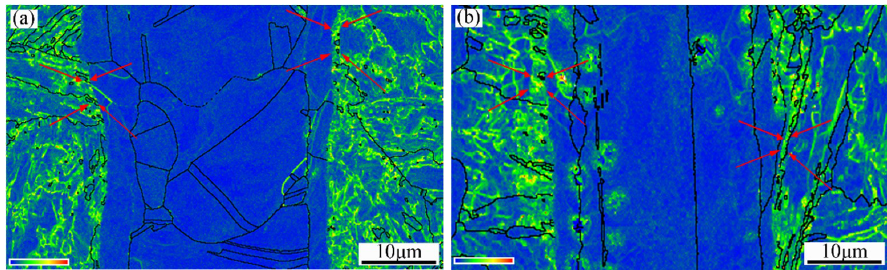
Figure 9. Kernel average misorientation (KAM) maps ( a ) before and ( b ) after tempering treatment.